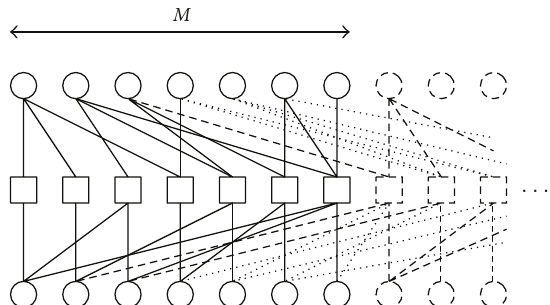
Figure 2: Tanner graph corresponding to Figure 1. The circles indicate symbol nodes, and the squares indicate parity-check